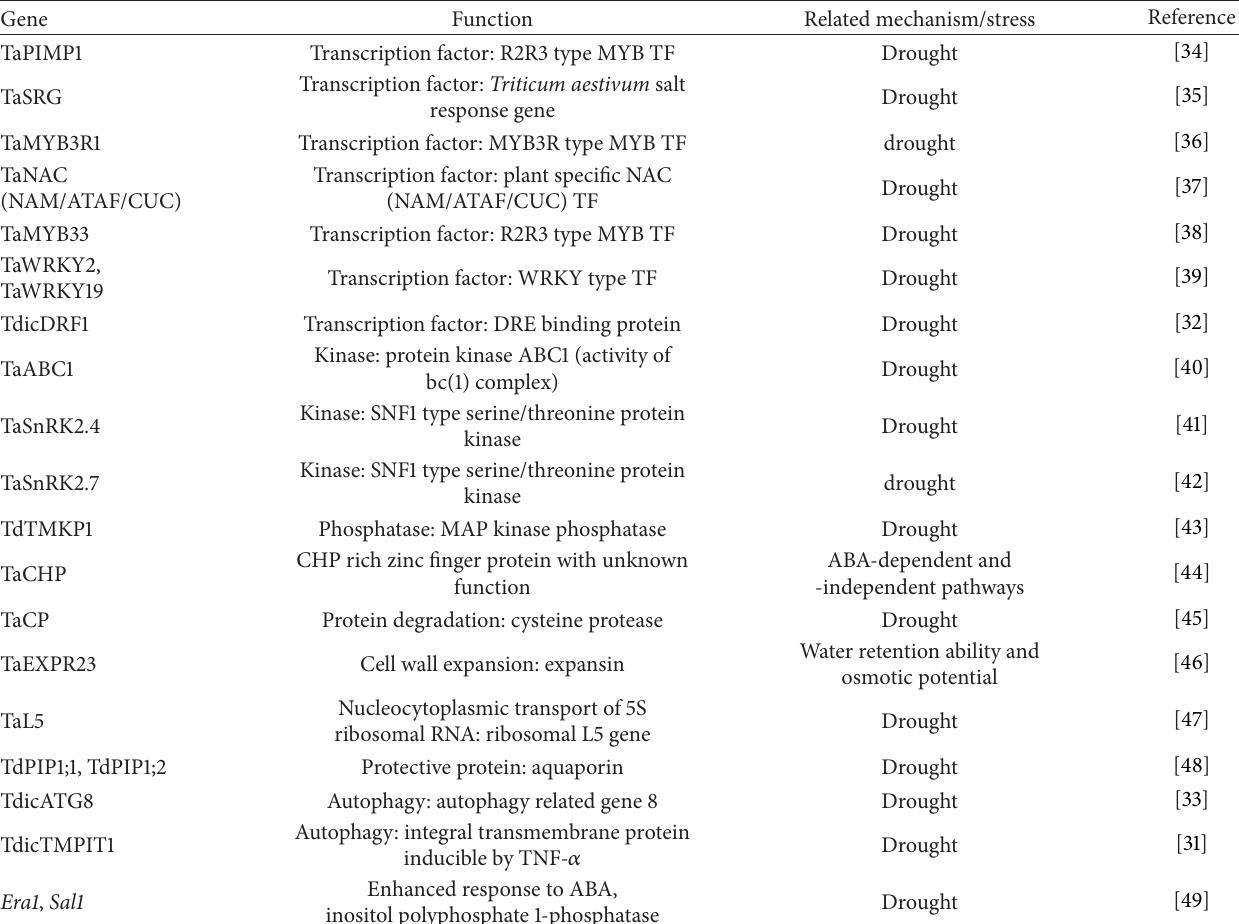
Table 2: List of identified and characterized drought related genes in the last three